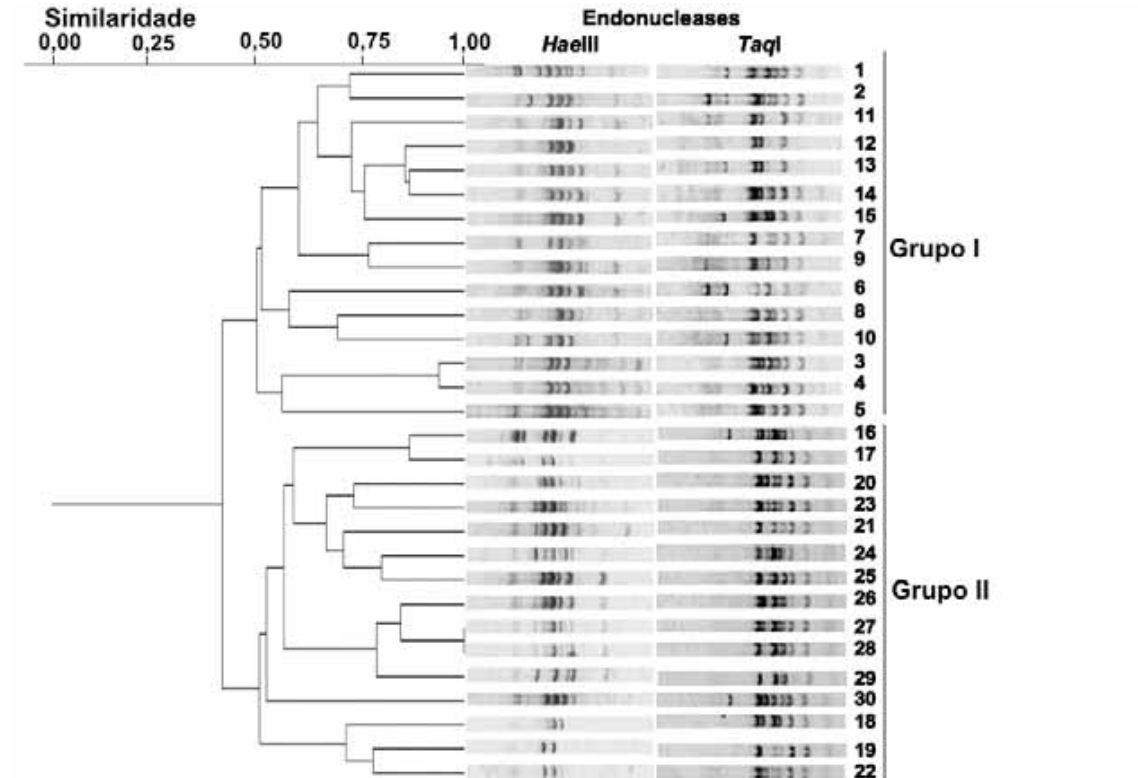
Figura 2. Dendrograma de similaridade, mostrando a análise de agrupamento baseada no polimorfismo dos fragmentos de restrição dos genes nifH amplificados a partir do DNA bacteriano extraído do colmo de milho cultivado em diferentes regiões do Rio Grande do Sul, após análise de agrupamento baseada na presença/ausência dos fragmentos de